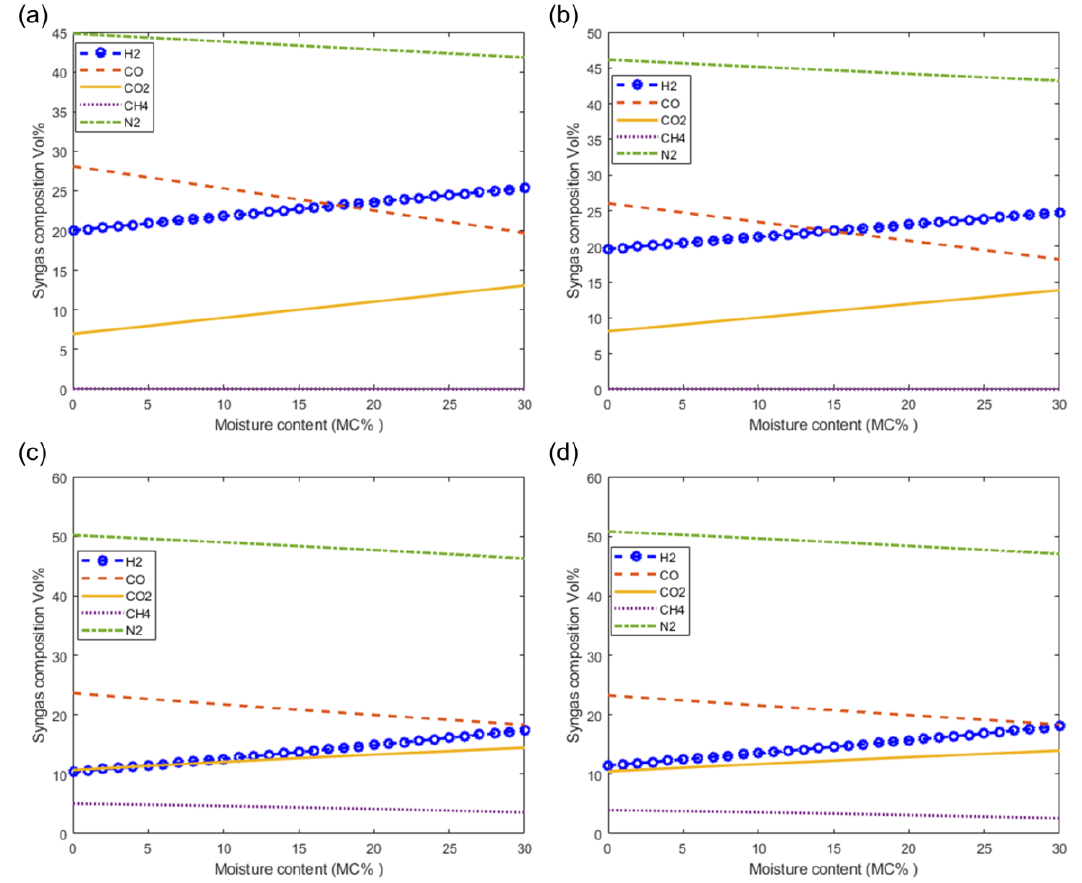
Figure 8. Effect of moisture on syngas composition at T = 1073 K. As predicted by models ( a ) M1, ( b ) M2, ( c ) M3 and ( d ) M4.